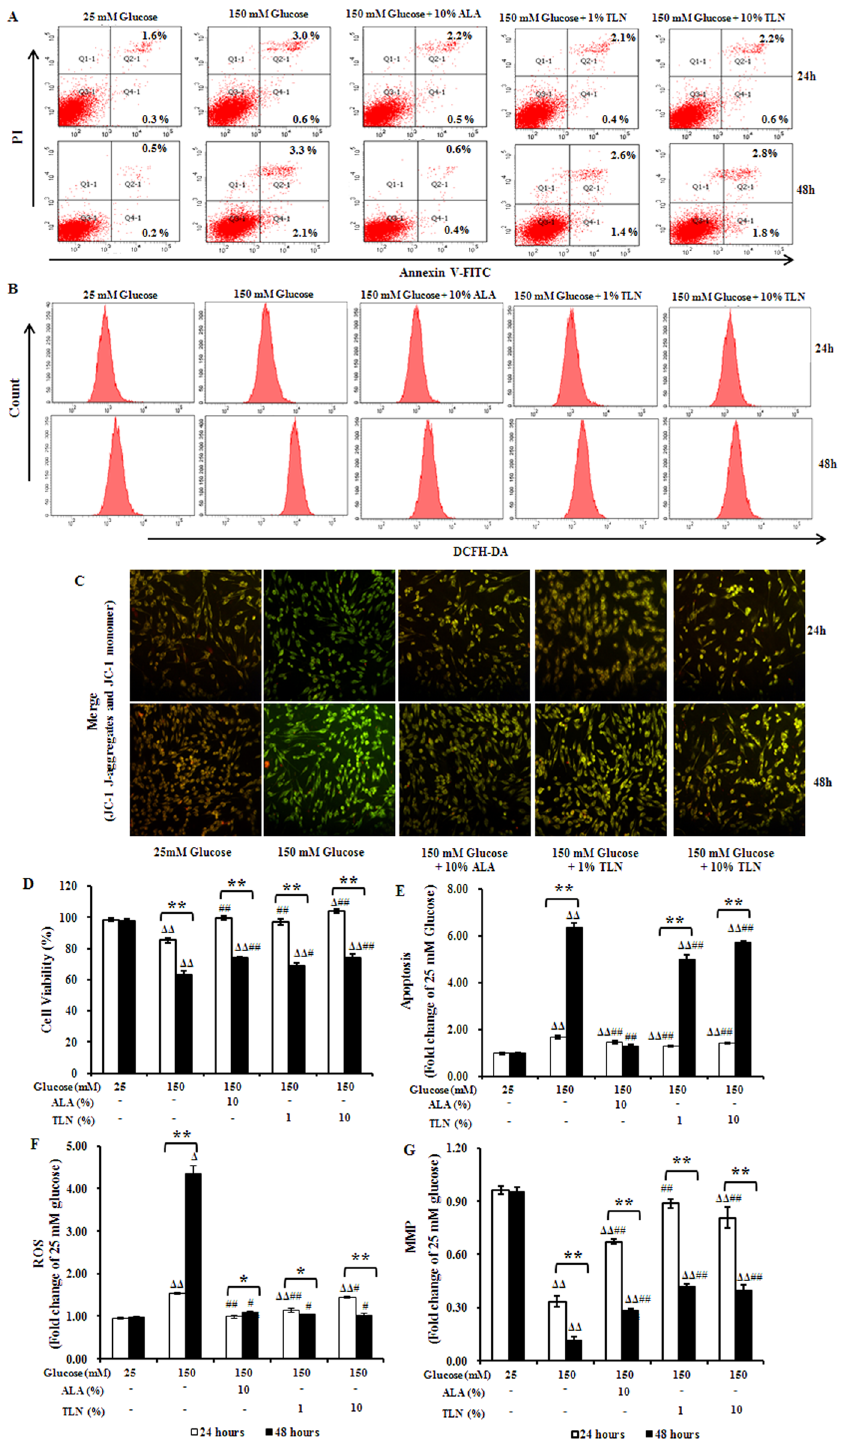
Figure 3. Apoptosis and oxidative stress in RSC96 cells treated with TLN and exposed to high glucose. ( A ) FACS apoptosis assay results using FITC-Annexin V and PI staining at 24 h and 48 h. ( B ) Intracellular ROS production measured with FACS analysis using DCHF-DA as a fluorescent dye at 24 h and 48 h. ( C ) The mitochondrial membrane potential (MMP) detected using JC-1. The decrease in MMP is reflected by a decrease in red fluorescence in the merged images. ( D ) Cell viability determined using MTT assay. (E–G) Levels of apoptosis, MMP and ROS shown as fold changes relative to 25 mM glucose-treated cells. Data are represented as the mean ± S.E.M. Δ P < 0.05, ΔΔ P < 0.01 vs. 25 mM glucose groups; # P < 0.05, ## P < 0.01 vs. 150 mM glucose groups; * P < 0.05, ** P < 0.01 vs. treated after 24 hours. Data were analyzed by One-way ANOVA followed by least significant difference or Tambane’s T2 analysis. Student’s unpaired t-test compared to 24 hours’ time point. (n = 4 per